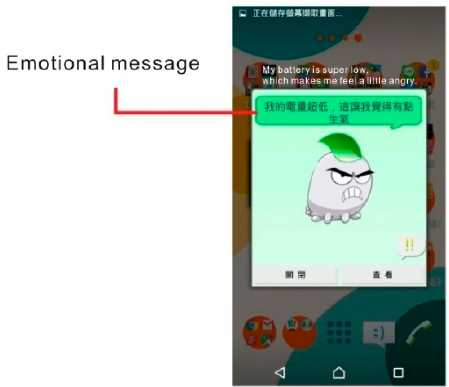
Figure 7. An emotional message generated by the system.